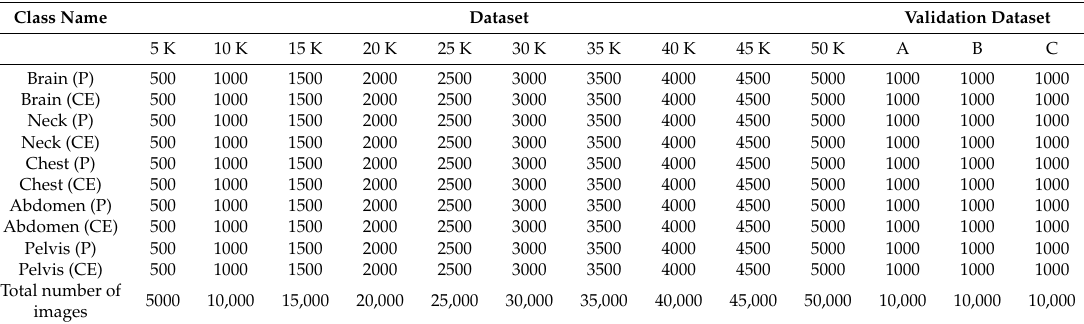
Table 1. Names of datasets and the number of images in each